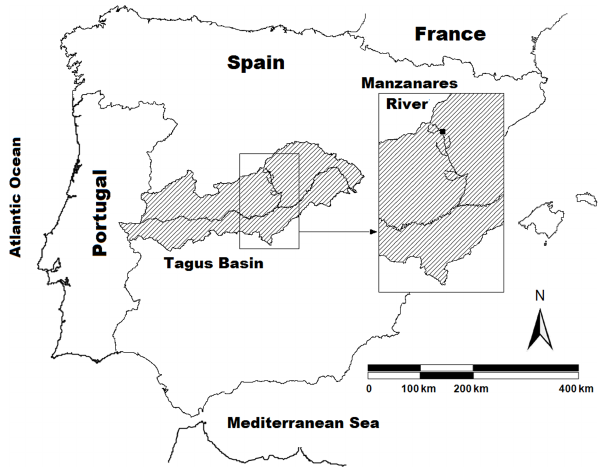
Fig. 2. Location of the Santillana